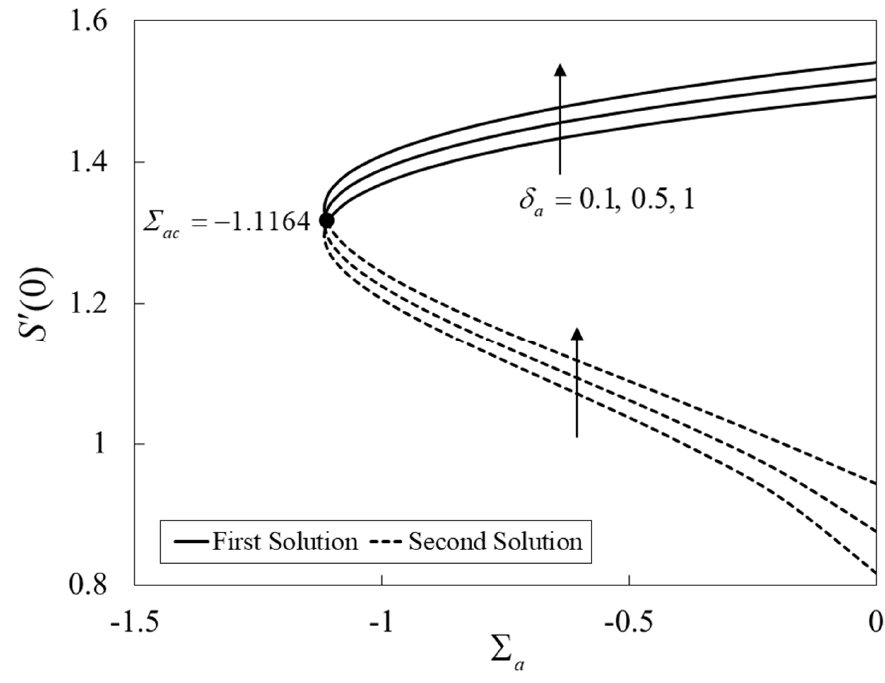
Figure 8. Variation in the local Sherwood number S (cid:48) ( 0 ) with Σ a for different values of δ a